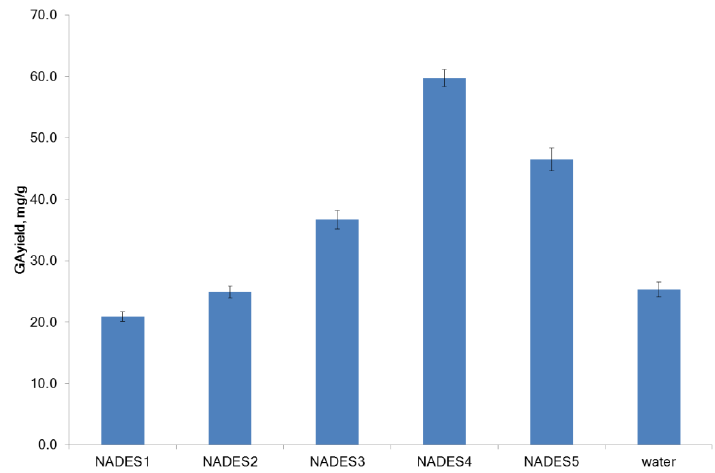
Figure 1. The yield of glycyrrhizic acid in NADES and water.